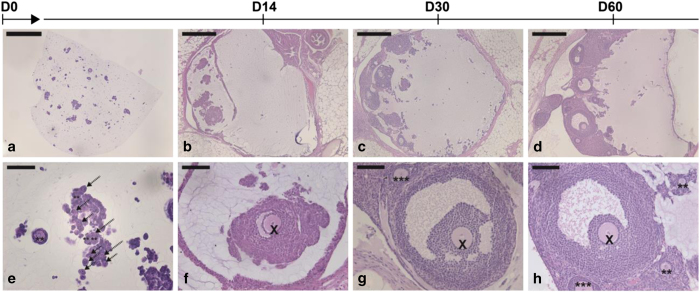
Folliculogenesis in PEG grafts. (a–d) Over 60 days, massive volumetric expansion was observed during the complete folliculogenesis, beginning with the (e) mixed population of primordial and primary follicles to (f–h) antral follicles, and more tissue regeneration occurred (b–d). Antrum formation was observed by day 14. By day 30 and 60, multiple antral follicles were observed. (Primordial (dotted arrow), Primary follicle (**), Secondary follicle (***), Antral follicle (X)), Scale Bar=500 μm (a–d), 50 μm (e), 100 μm (f–h).